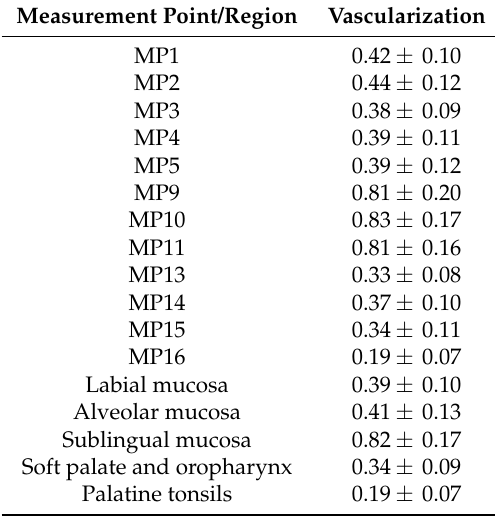
Table A2. Mean vascular density of specific oral measurement points and regions. Due to the limited visualization of the lamina propria for the inner cheek and the hard palate, vascularization by major vessels of both regions could not be